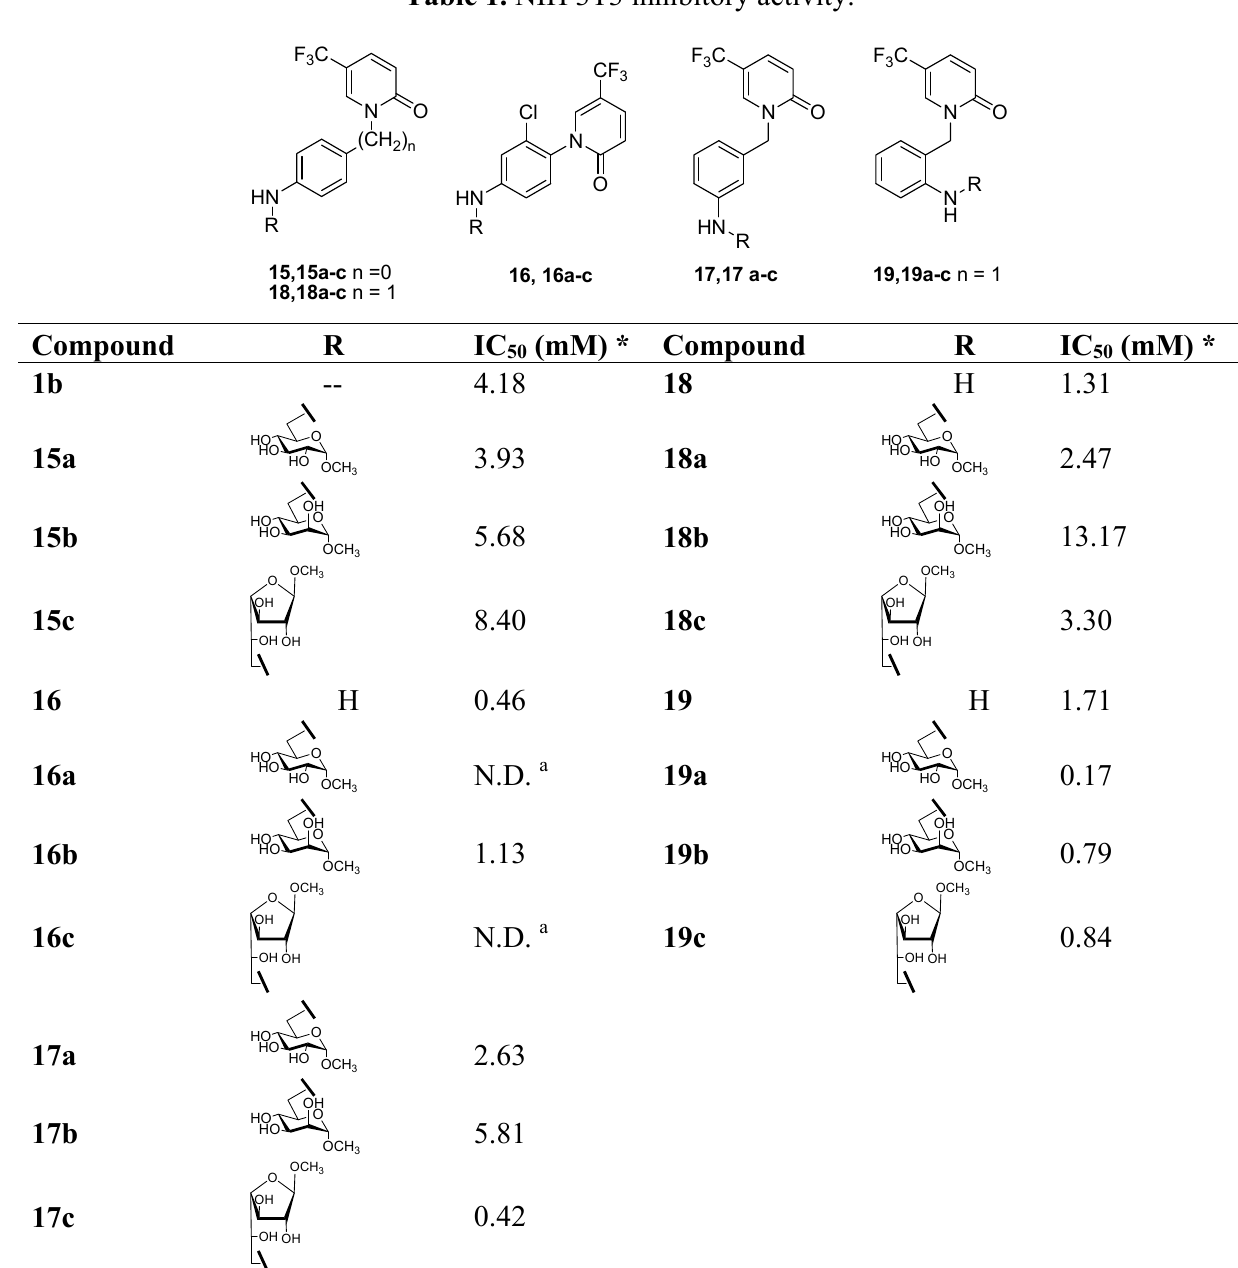
Table 1. NIH 3T3 inhibitory